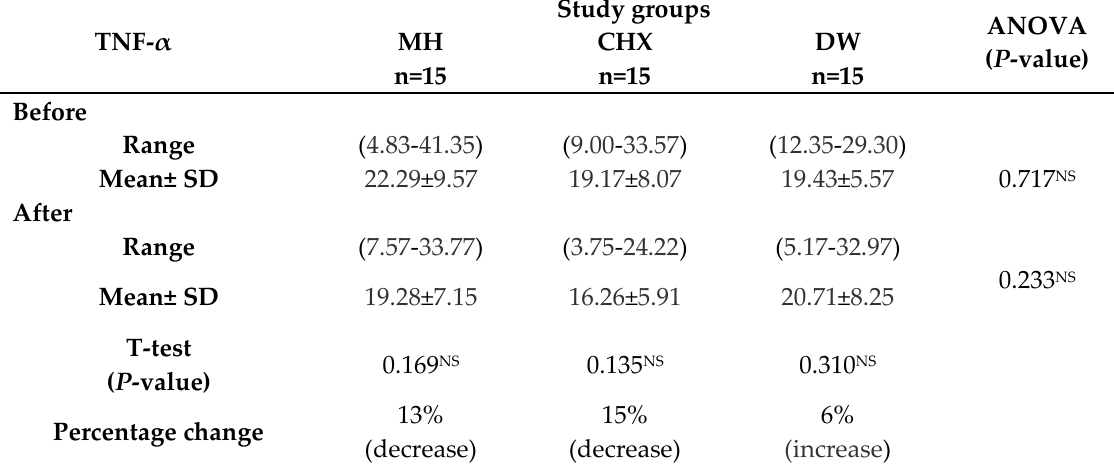
Table 2: mean value of TNF- α in study groups before and after mouthwash use.